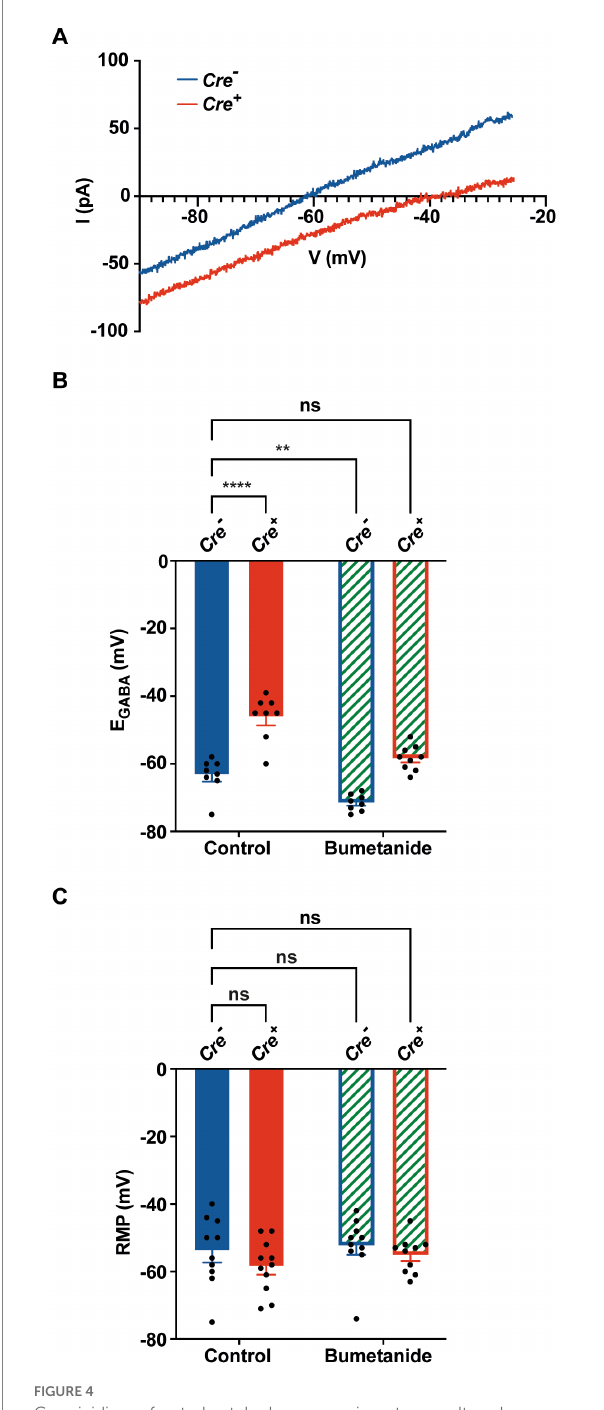
FIGURE 4 Gramicidin perforated patch clamp experiments on cultured hippocampal primary Cre + and Cre − neurons. (A) Examples of current–voltage curves of GABA currents elicited by puffing GABA at the neuronal cell body in isolated hippocampal neurons Cre − (blue) and Cre + (red). I-V curves are recorded via gramicidin perforated patch clamp and obtained after subtracting the leak current measured at the beginning of each experiment. (B) Positive E GABA shift from − 63.4 ± 1.9 mV in Cre − neurons ( n = 8) to − 46.3 ± 2.4 mV in Cre + neurons ( n = 8). Bumetanide negatively shifted E Cl of Cre + neurons back to physiological values ( − 58.3 ± 1.2 mV, in Cre + neurons ( n = 9) and to − 71.5 ± 0.9 mV in Cre − neurons ( n = 8). Values are mean ± SEM; *** p -value ≤ 0.001, ** p -value ≤ 0.01; two-way ANOVA with the Bonferroni post-hoc test. (C) Resting membrane potential values